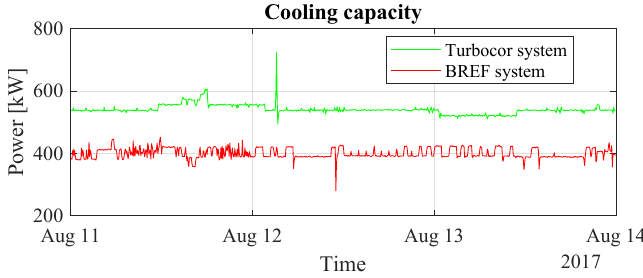
Figure 16. Cooling capacity on 11–13 August